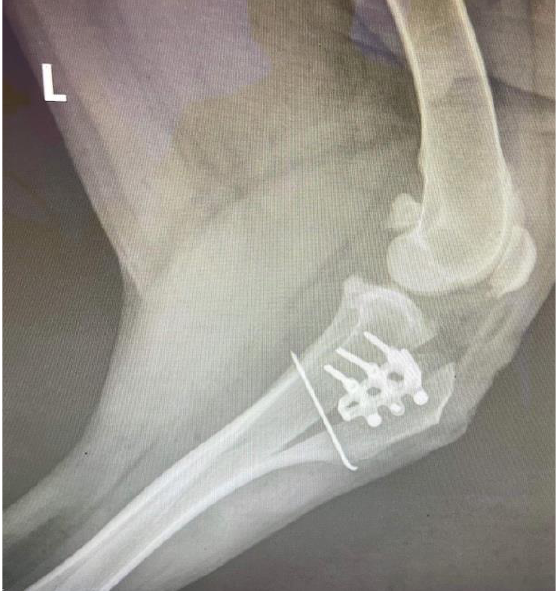
Figure 2. Immediate postoperative appearance of the implants.